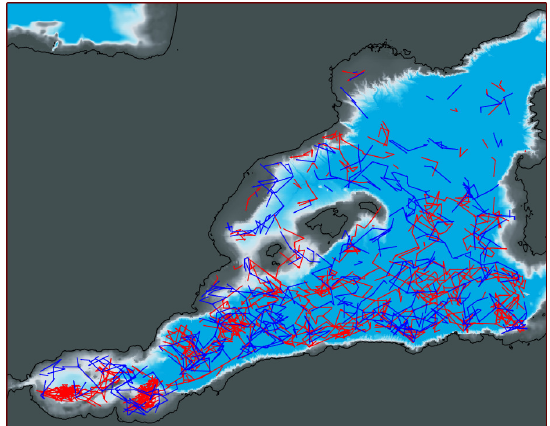
Figure 10. Tracked movements of AC (red arrows) and C (blue arrows) eddies in the westernmost Western Mediterranean